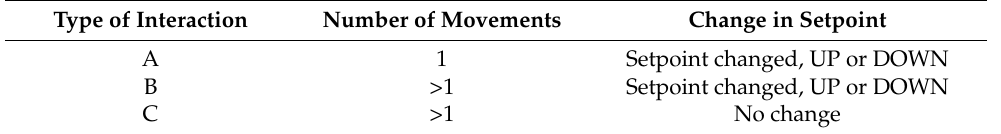
Table 1. Types of user interactions with heat controls.